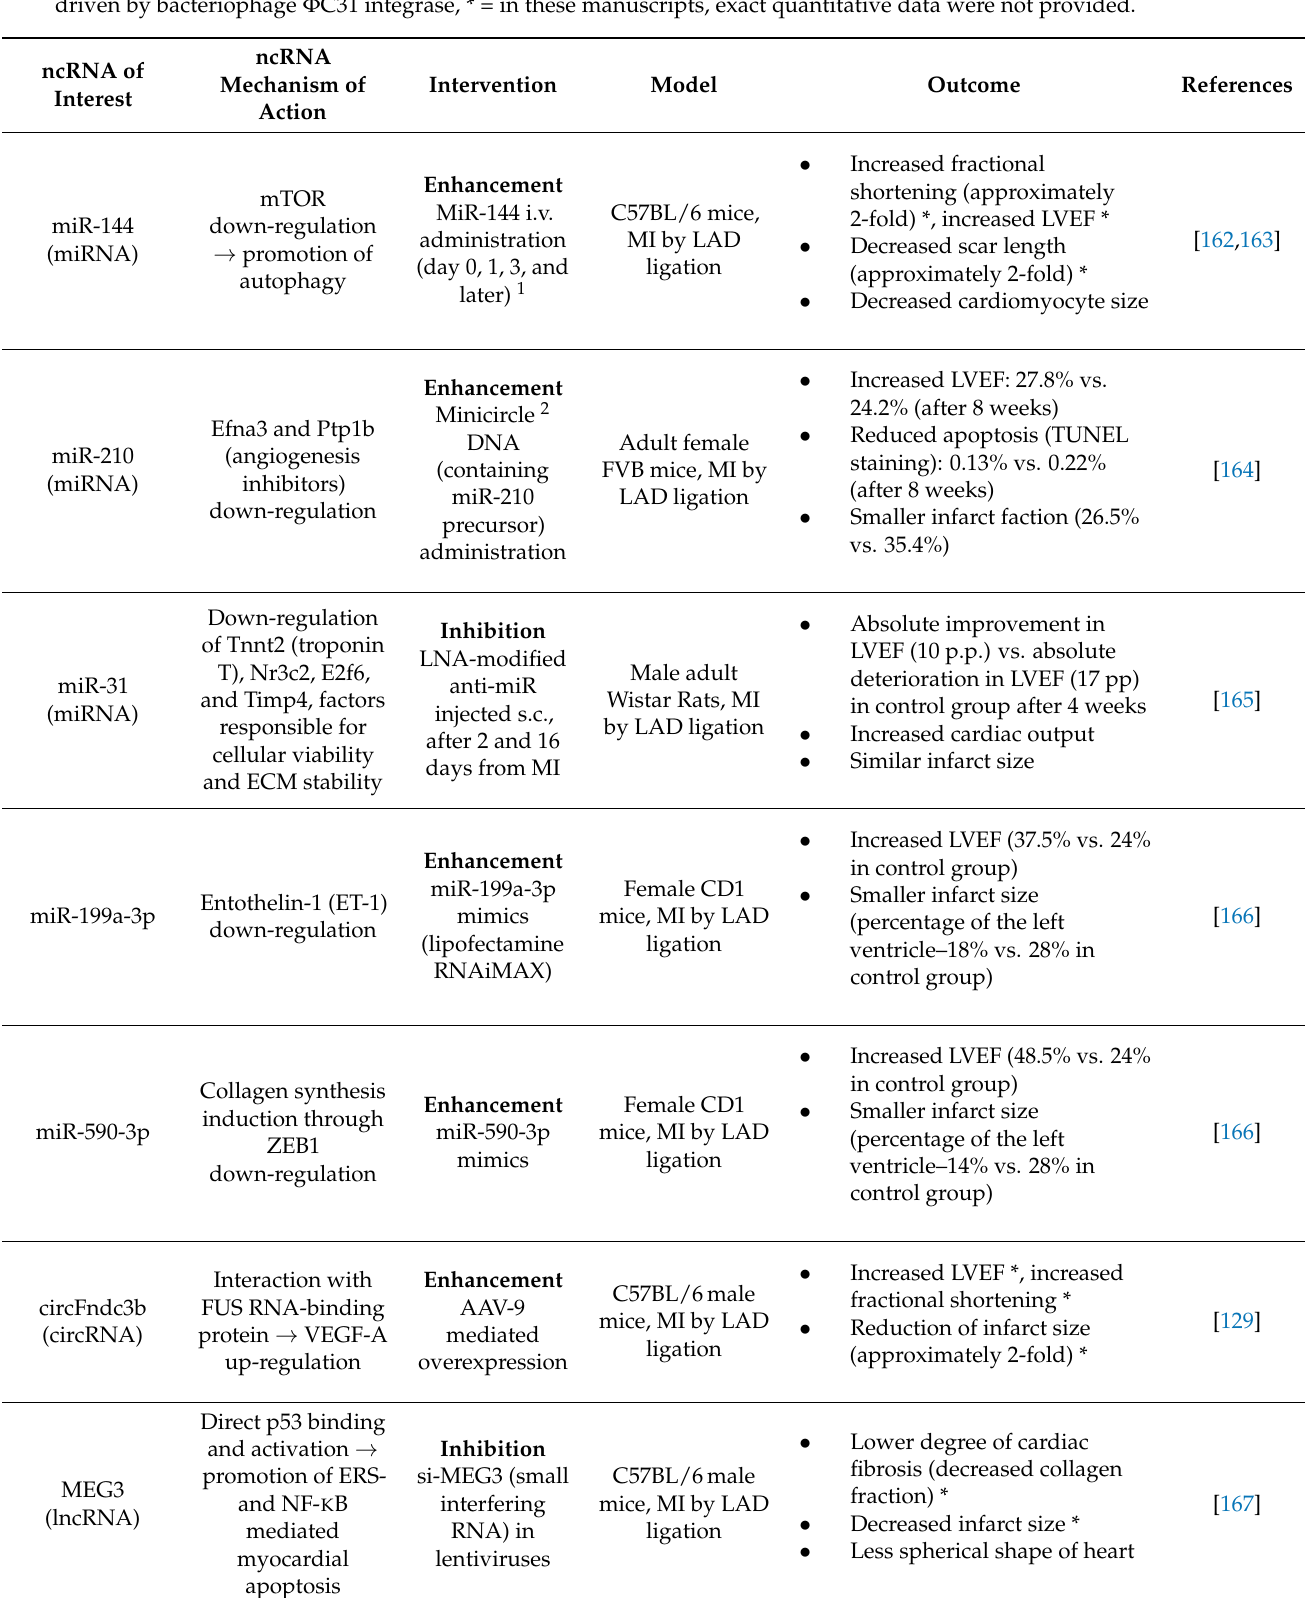
Table 4. The exemplary therapies upon ncRNAs and their outcomes in animal studies. 1 = injections at day 0, 1, 3 and then every 3 days until 28th day after myocardial infarction, 2 = minicircles, products of site-specific intramolecular recombination driven by bacteriophage Φ C31 integrase, * = in these manuscripts, exact quantitative data were not